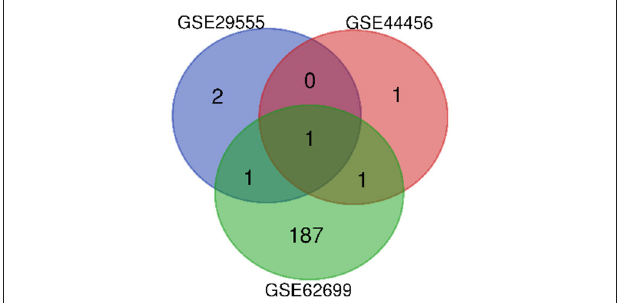
FIGURE 1 | Venn diagram showing DEGs between three microarray databases for genes associated with alcohol dependence. The three datasets have one overlapping gene, SERPINA3 .